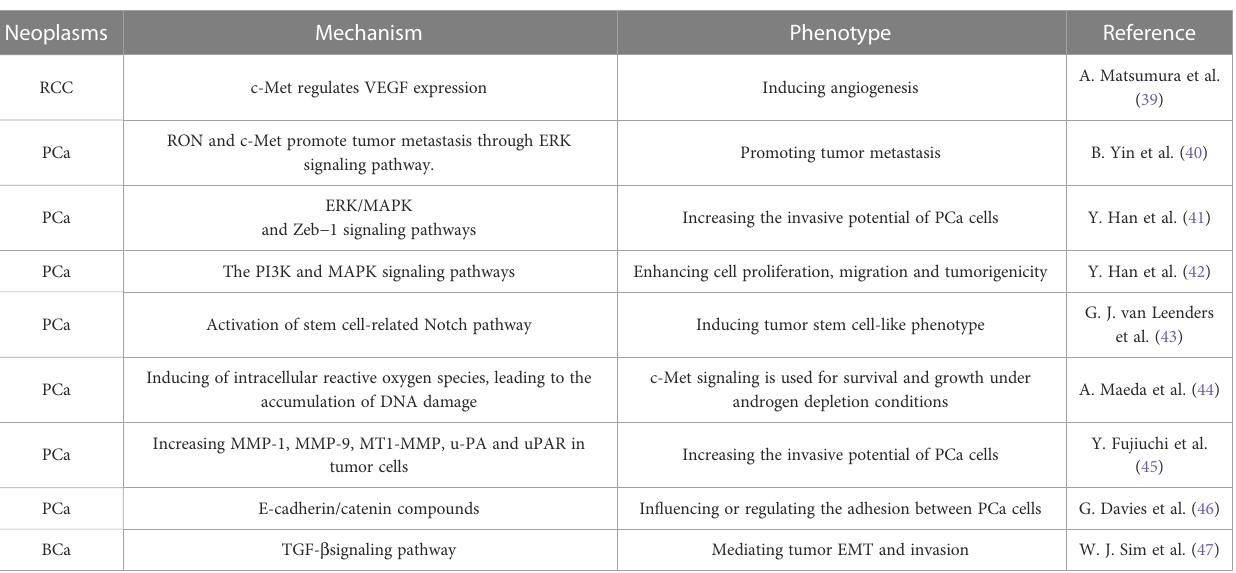
TABLE 1 Activation of HGF/c-Met signal in urologic neoplasms and related